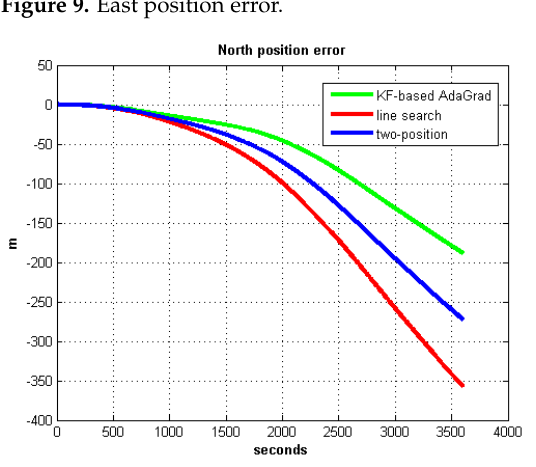
Figure 10. North position error.